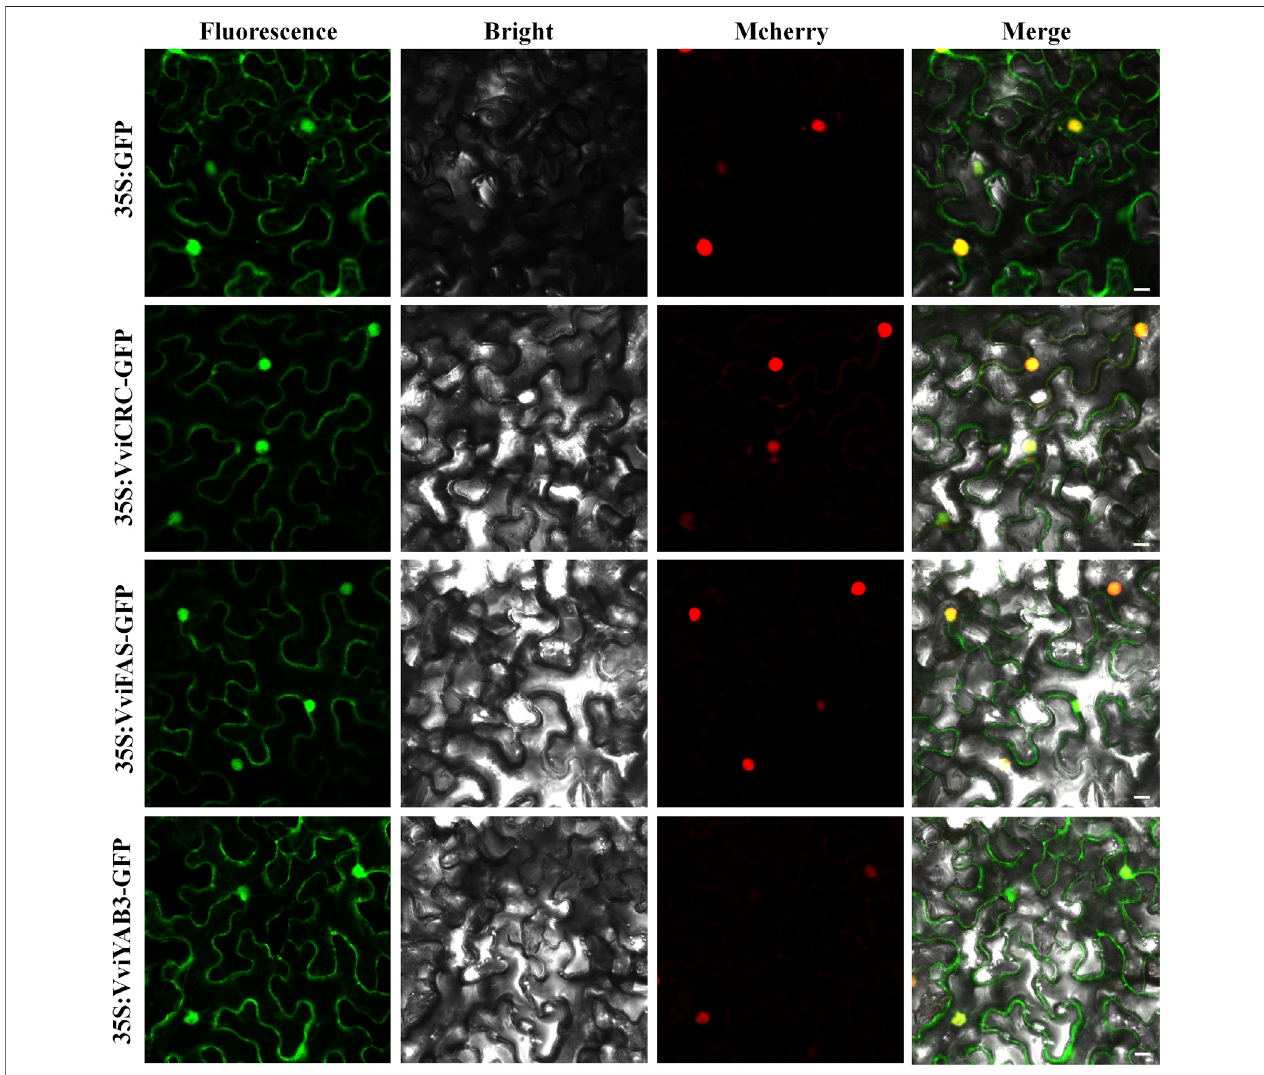
FIGURE9| Theleavesof3-to5-week-old Nicotianabenthamiana plantsweretransientlytransformed withcontrol,35S:VviCRC-GFP,35S:VviFAS-GFP,and35S: VviYAB3-GFP. The NLS-mCherry tagged red fl uorescent protein was co-expressed. Bar: 25 μ m.